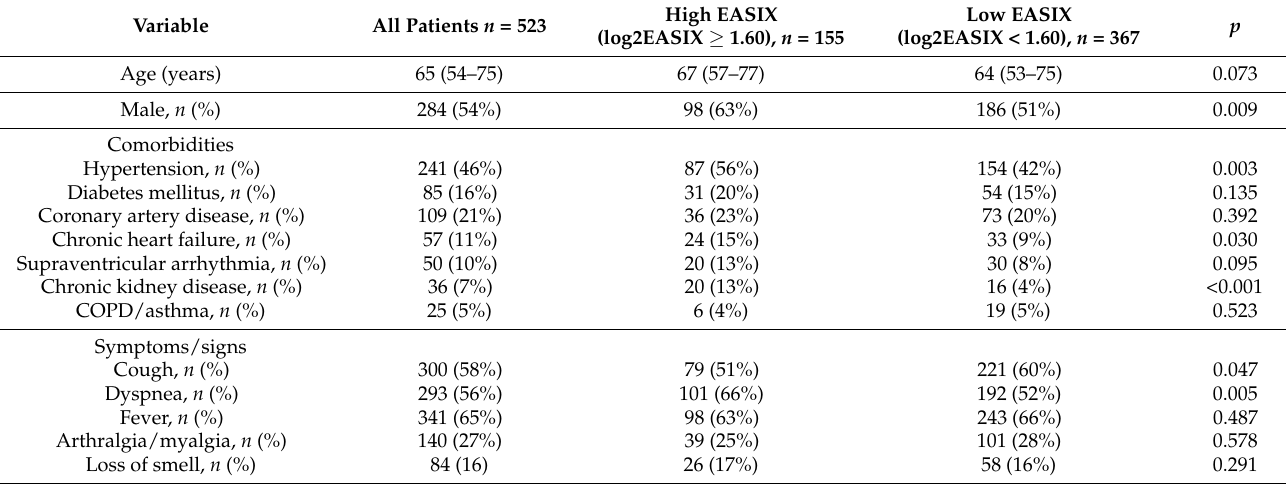
Table 2. Clinical characteristics of COVID-19 patients with high EASIX versus low